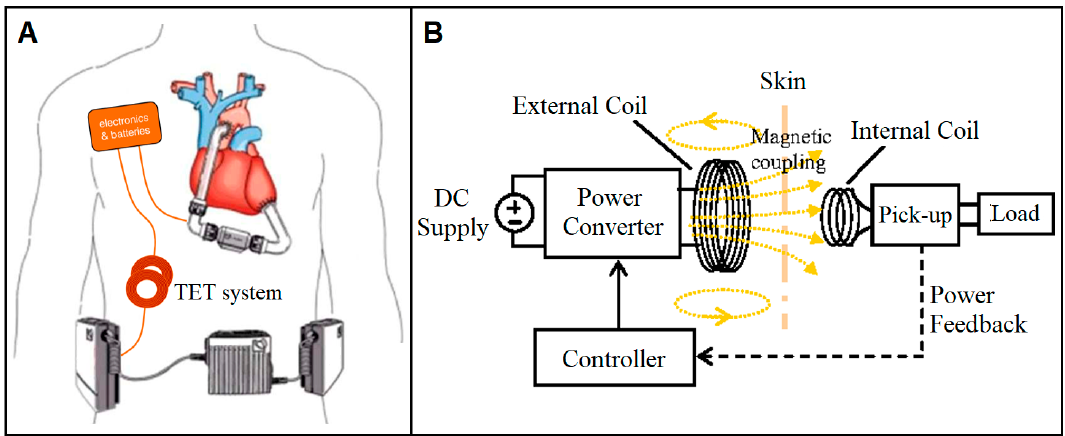
Figure 6. Schematics of the TET system ( A ) in patient use and ( B ) with an electromagnetic coupling between the internal and external coils located inside and outside of patient skin, respectively [100,101].